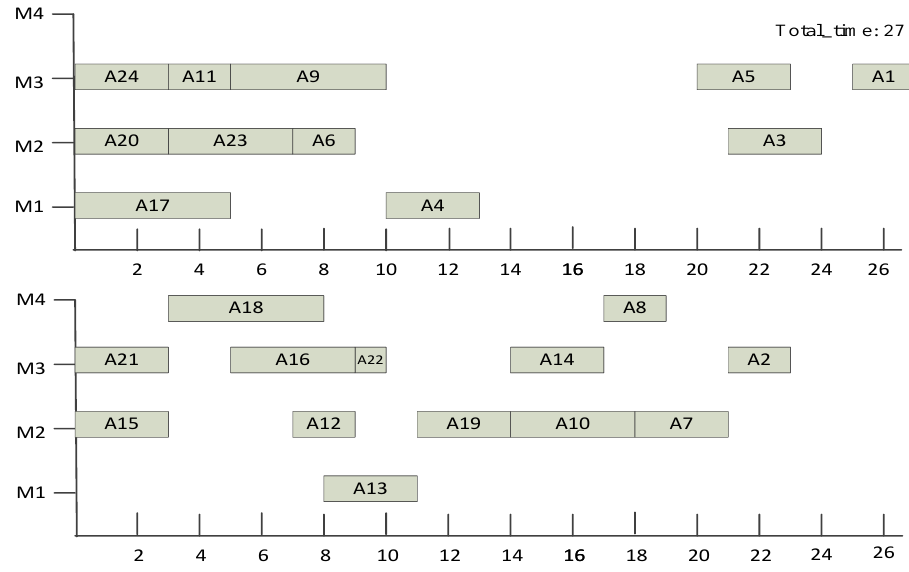
Figure 10. Gantt chart of algorithm scheduling results in the Ref. [17].